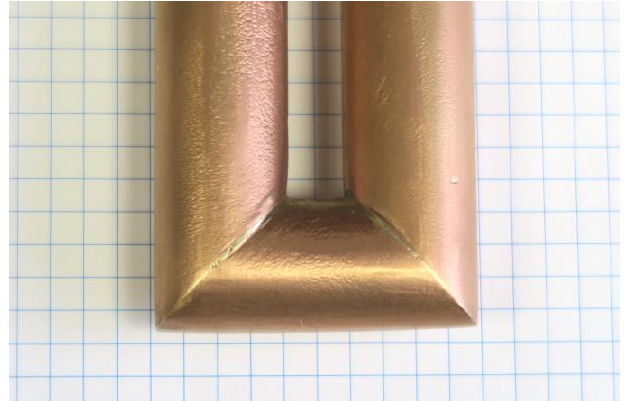
Figure 9: The short-circuited end of the second two-wire transmission line with the slanted welding areas. The gap between the wires is nominally 8 mm , as can be estimated from the grid on the graph paper of spacing 5 mm